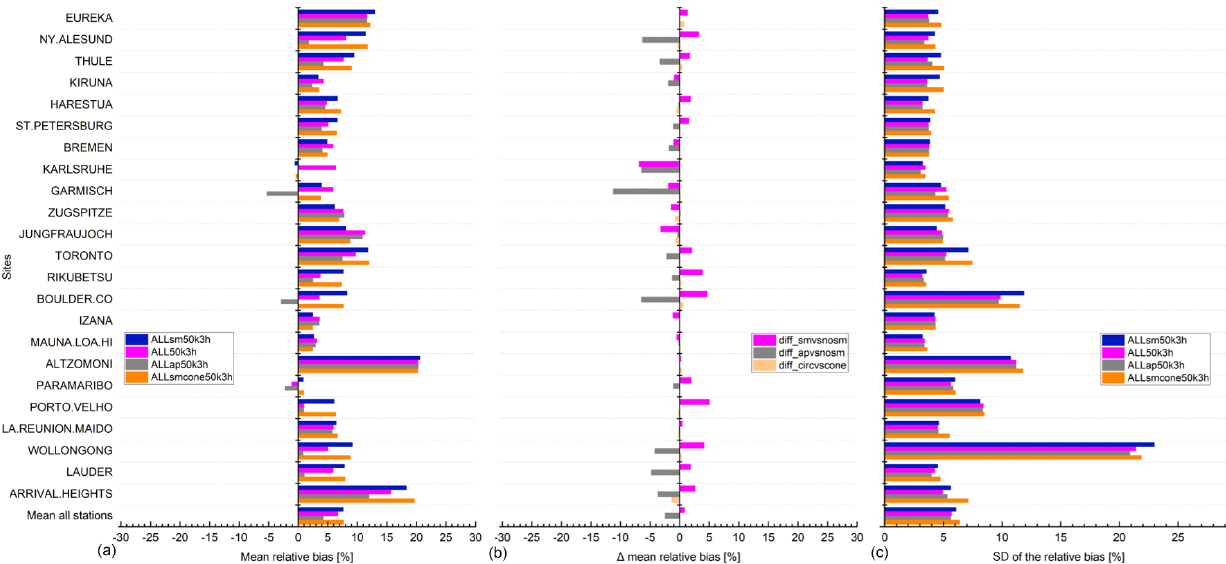
Figure 26. S5P CO column validation results against NDACC CO column data at 23 stations within the period between November 2017 and September 2020. (a) Bar chart of mean relative bias ((SAT – GB)/GB) in percent; (c) standard deviation of the relative bias in percent; (b) difference of the mean relative bias for validation cases (ALL50k3h, ALLap50k3h, ALLsmcone50k3h) in percent against the reference case (ALLsm50k3h) in percent. Spatial co-location with radius of 50km or cone with 1 ◦ opening angle along the FTIR line of sight and time co-location of ± 3h around the satellite overpass was used. The stations are sorted with decreasing